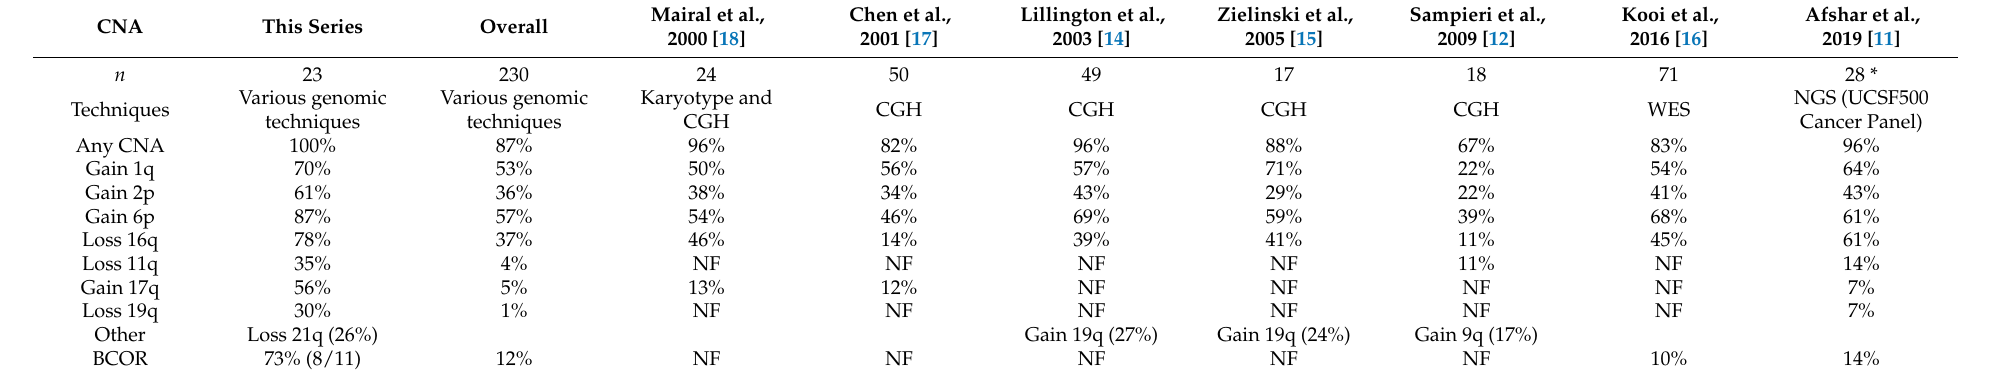
Table 2. Comparison of reported copy number alterations (CNA) (besides RB1 ) in series with mostly intraocular cases and this